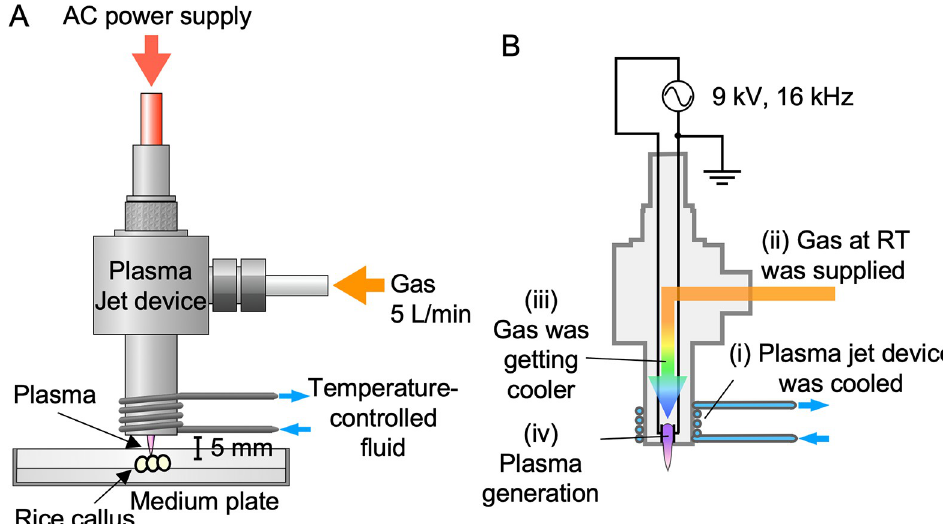
Fig 1. Plasma treatment by a multi-gas temperature controllable plasma jet. (A) Schematic image of plasma irradiation of plant tissues. Rice calli placed on a medium plate were irradiated with plasma at a distance of 5 mm. (B) Scheme for temperature-controlled plasma generation. The device producing the multi-gas temperature-controllable plasma jet was cooled by temperature-controlled fluid (i). N 2 or CO 2 at room temperature (RT) was supplied to a metal tube outside the device (ii). The gas was cooled via heat exchange (iii). The cooled gas flowed between the internal high- voltage electrodes upon application of AC voltage, generating room-temperature plasma (20–30˚C) by discharge